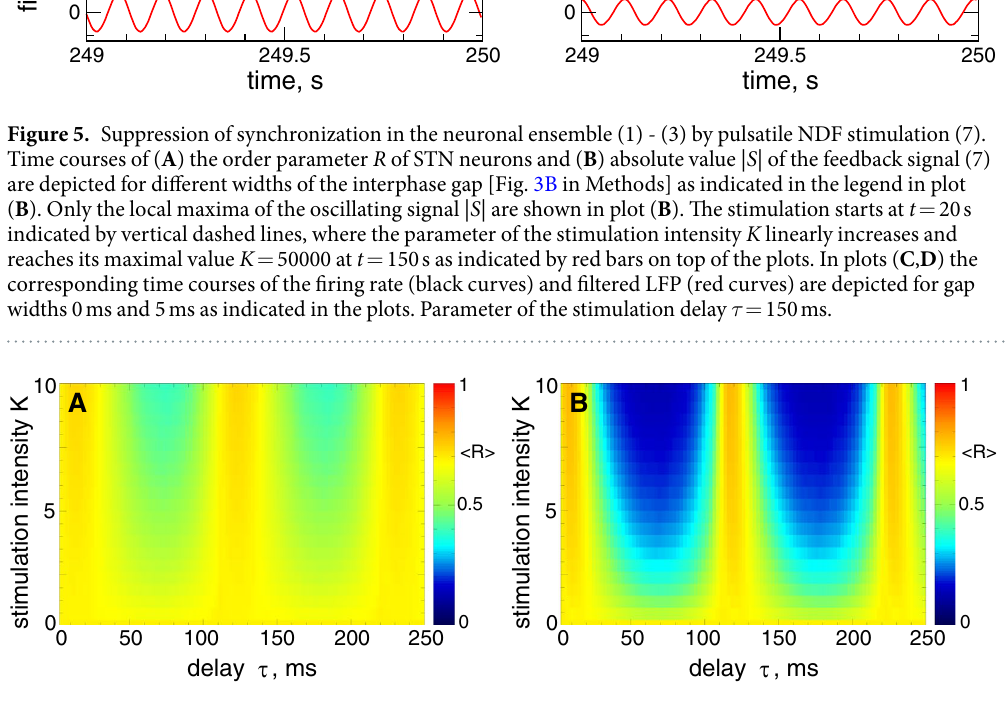
intensity K [Fig. 8A, black empty triangles], and the pulsatile LDF stimulation with interphase gap can induce a well-pronounced desynchronization as reflected by small values of 〈 R 〉 . Moreover, such a stimulation protocol requires a much smaller amount of the administered stimulation [Fig. 8A, black filled triangles], although it slowly increases as K grows. Such a behavior of the stimulation signal is connected to the decay rate of the order parameter 〈 R 〉 (and the amplitude of the LFP). We found that 〈 R 〉 decays according to a power law ~ K γ with the exponent γ ≈ − 1, as illustrated in the insert in Fig. 8A. For the considered network of N = 200 STN neurons, the direct numerical fit gives, however, γ ≈ − 0.9, which may be caused by the finite-size effect 79 and leads to a slow increase of the amount of administered stimulation as K grows. The dynamics of the order parameter 〈 R 〉 and the amount of the administered stimulation 〈 | S | 〉 for the pulsa- tile NDF stimulation is illustrated in Fig. 8B versus parameter of the stimulation intensity K for selected optimal stimulation delay τ = 150 ms [Fig. 7]. As for the pulsatile LDF stimulation, the order parameter 〈 R 〉 gradually